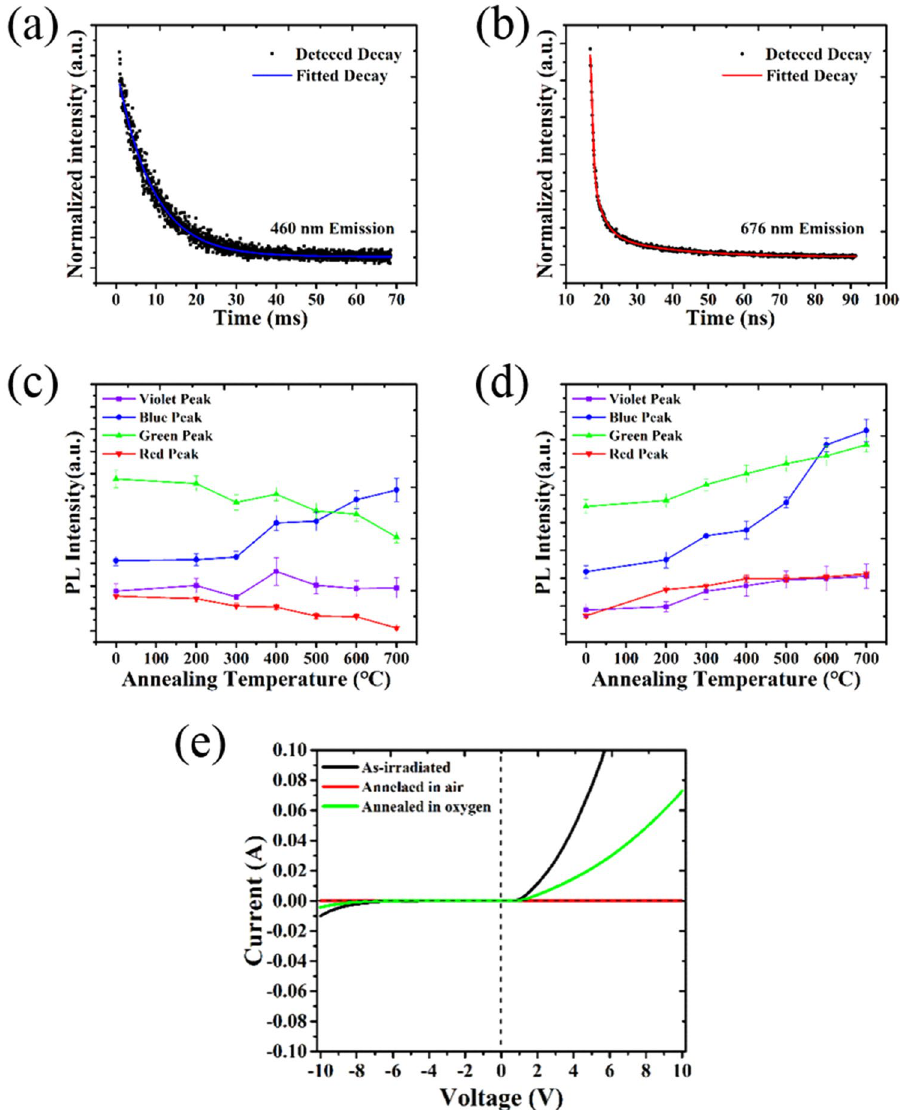
Figure 4. Fitted decay traces of emission at ( a ) 460 nm and ( b ) 676 nm of the white-PL sample. Intensities of the four deconvoluted peaks of samples annealed in ( c ) air and ( d ) oxygen at different temperatures. ( e ) Current– voltage curves of the white-PL sample and samples annealed in air and oxygen